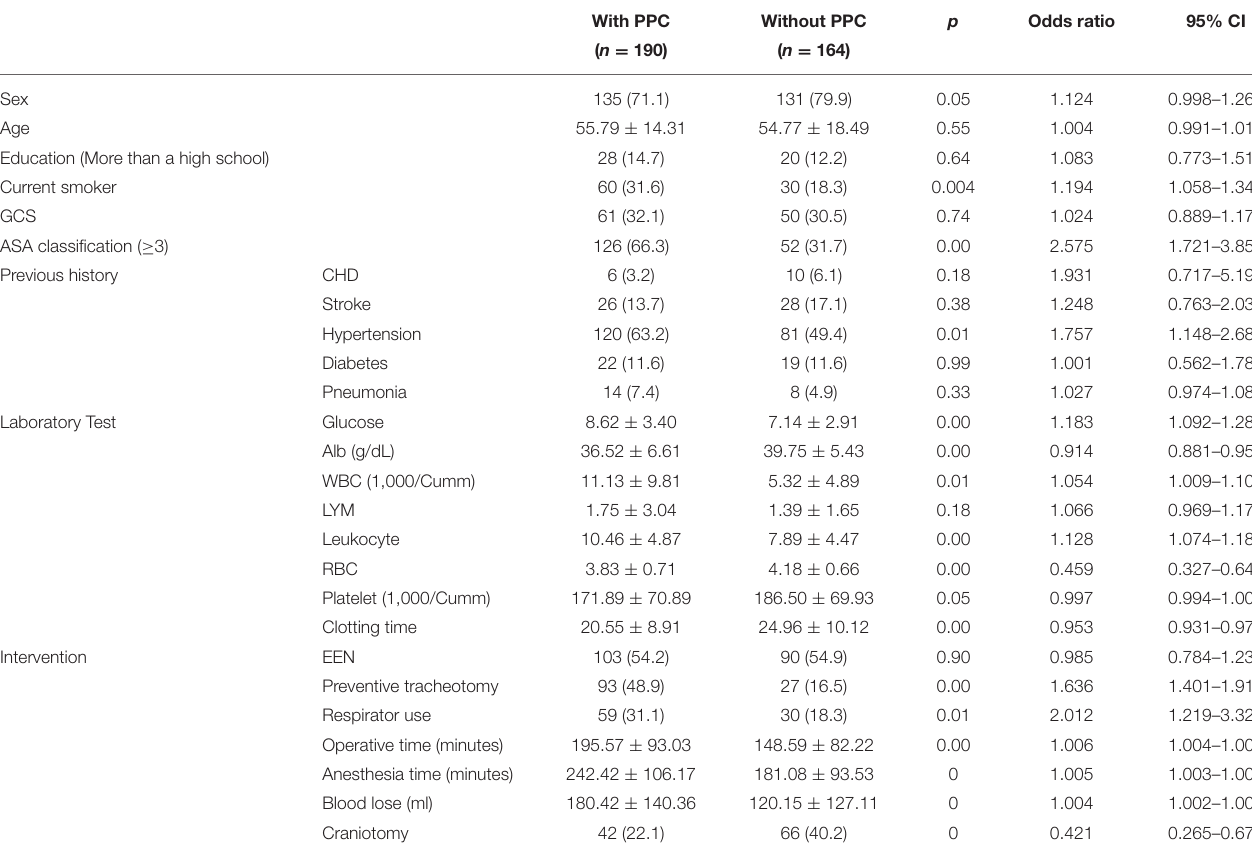
TABLE 1 | Results of univariate analysis for all feature variables.